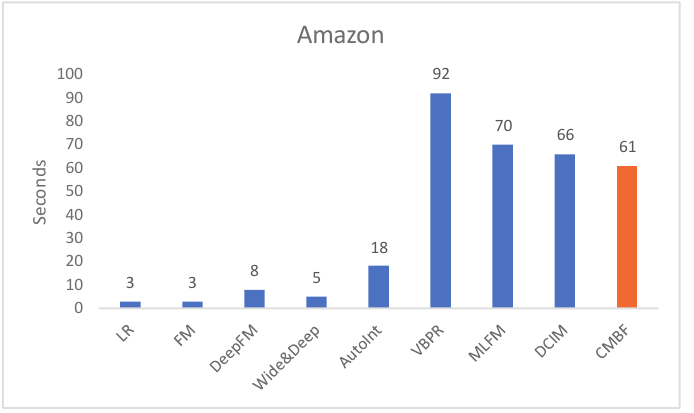
Figure 5. Run time per epoch of different algorithms on the Amazon